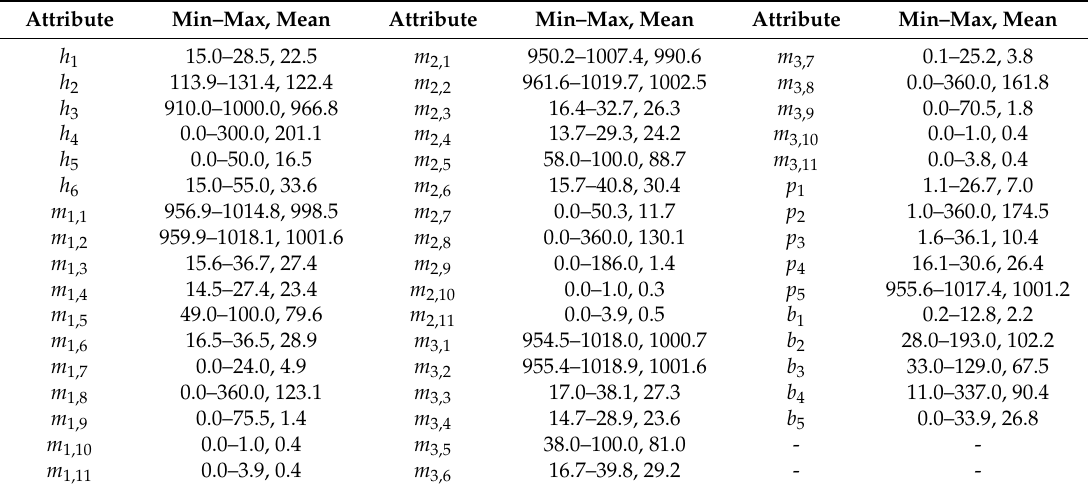
Table 2. Range and average values of data